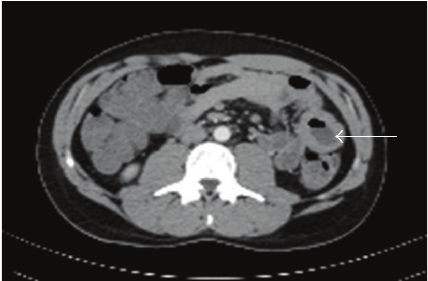
Figure 2: A computed tomography (CT) of abdomen shows lumen thickening with narrowing in distal jejunum